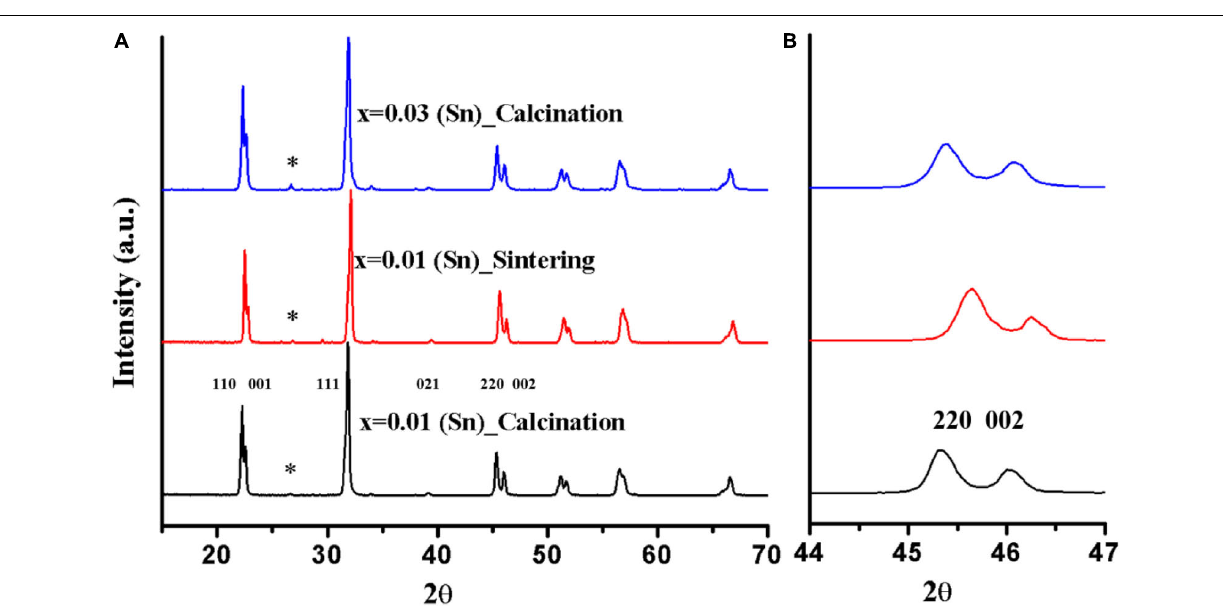
Frontiers in Materials |